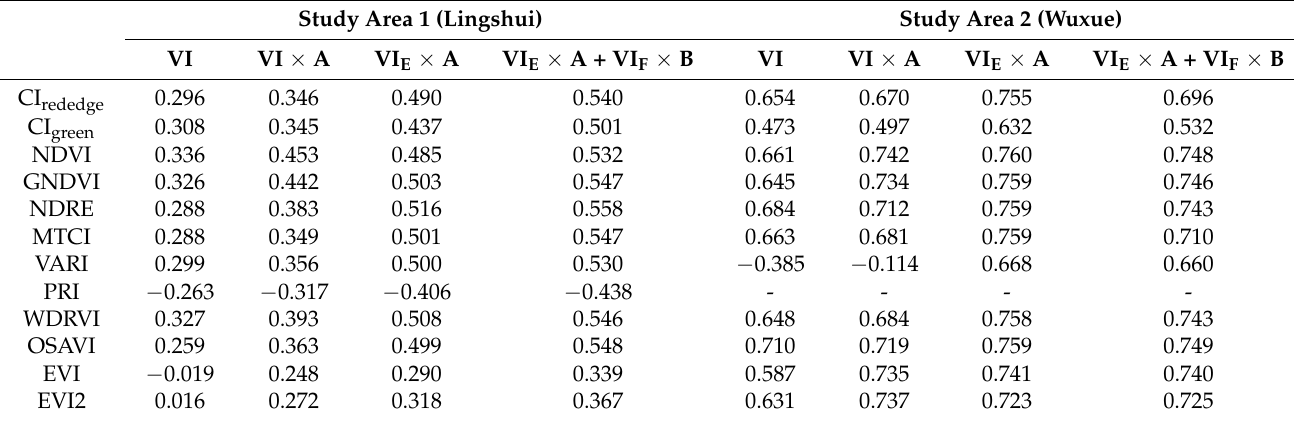
Table 4. The Pearson correlation coefficients of yield with VI, VI × A, VI E × A, and (VI E × A + VI F × B) at heading stage. Study Area 1 (Lingshui) Study Area 2